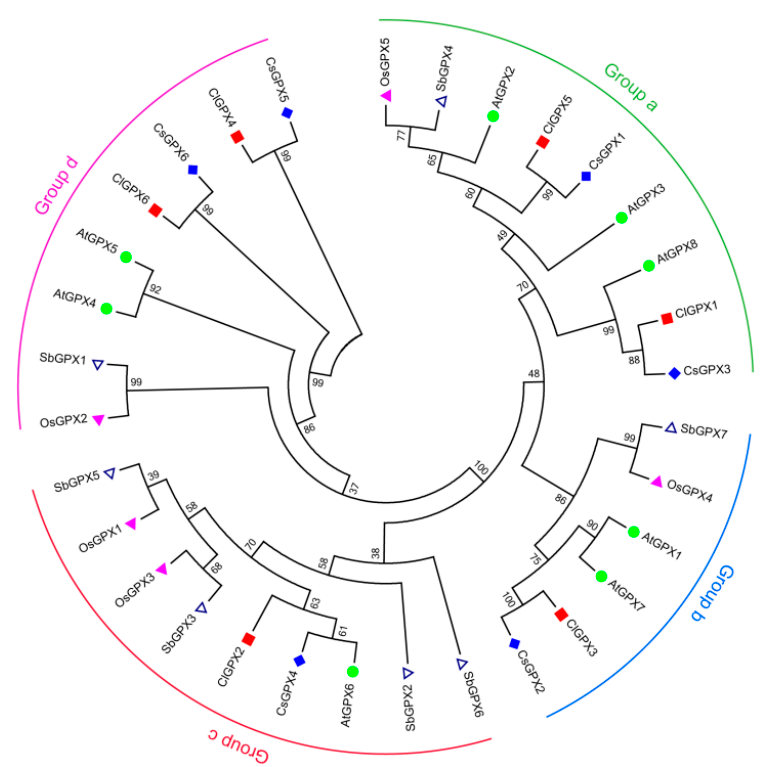
Figure 2. Phylogenetic relationships of the GPX gene family from watermelon and different plant species. The six cucumber, eight Arabidopsis , five rice, and seven sorghum GPX protein sequences were aligned by Clustal Omega and a phylogenetic tree was generated with the help of MEGA 5.0 using the neighbor-joining (NJ) method. The bootstrap value was set as 1000 replicates. The protein IDs of the GPX members are listed in Table S2.